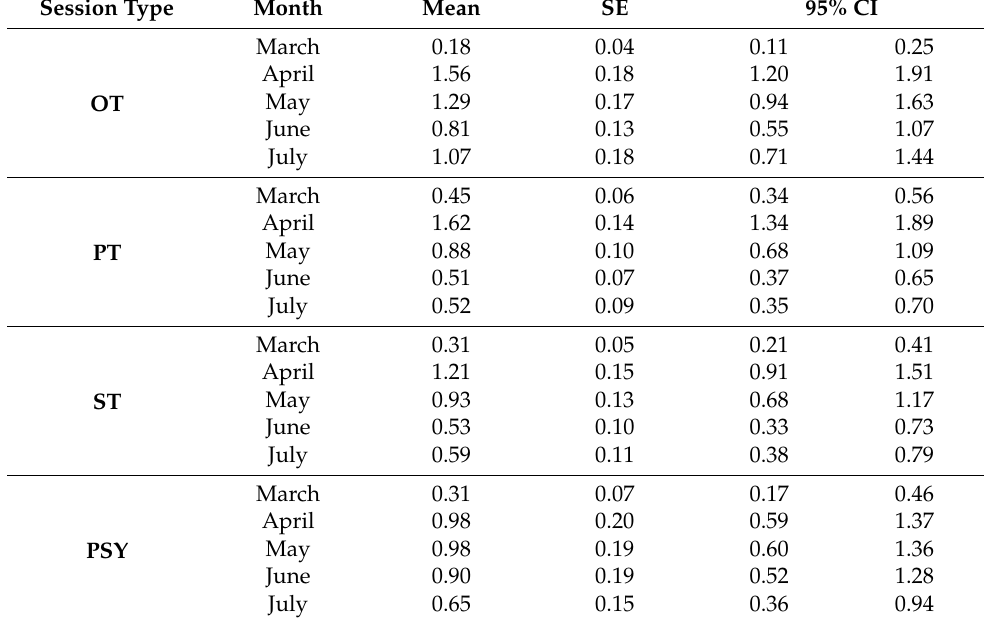
Figure 1. Average therapy sessions per type of therapy over 5-month time period. Table 3. Mean, Standard Error (SE) and 95% Confidence Intervals (CI) for each treatment type across time.